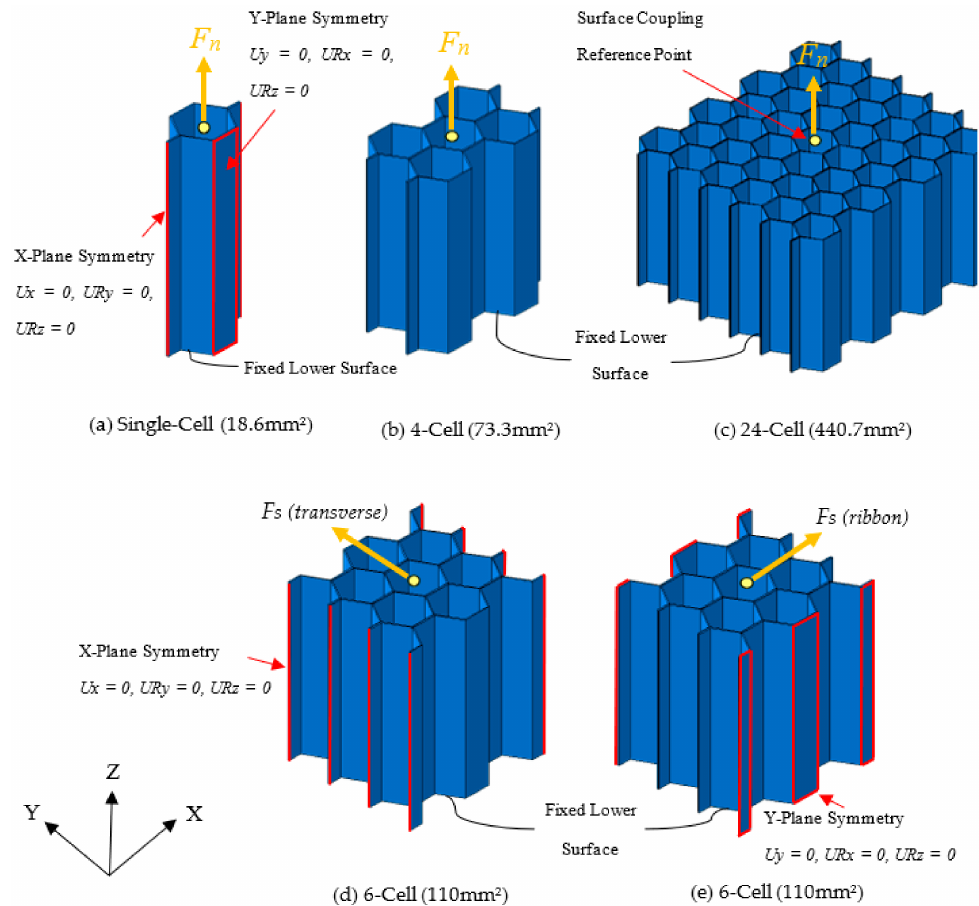
Figure 2. ( a ) Single-cell and ( b , c ) multi-cell models for the out-of-plane tension and compression, and ( d , e ) 6-cell model for the out-of-plane shear in the transverse and ribbon direction,